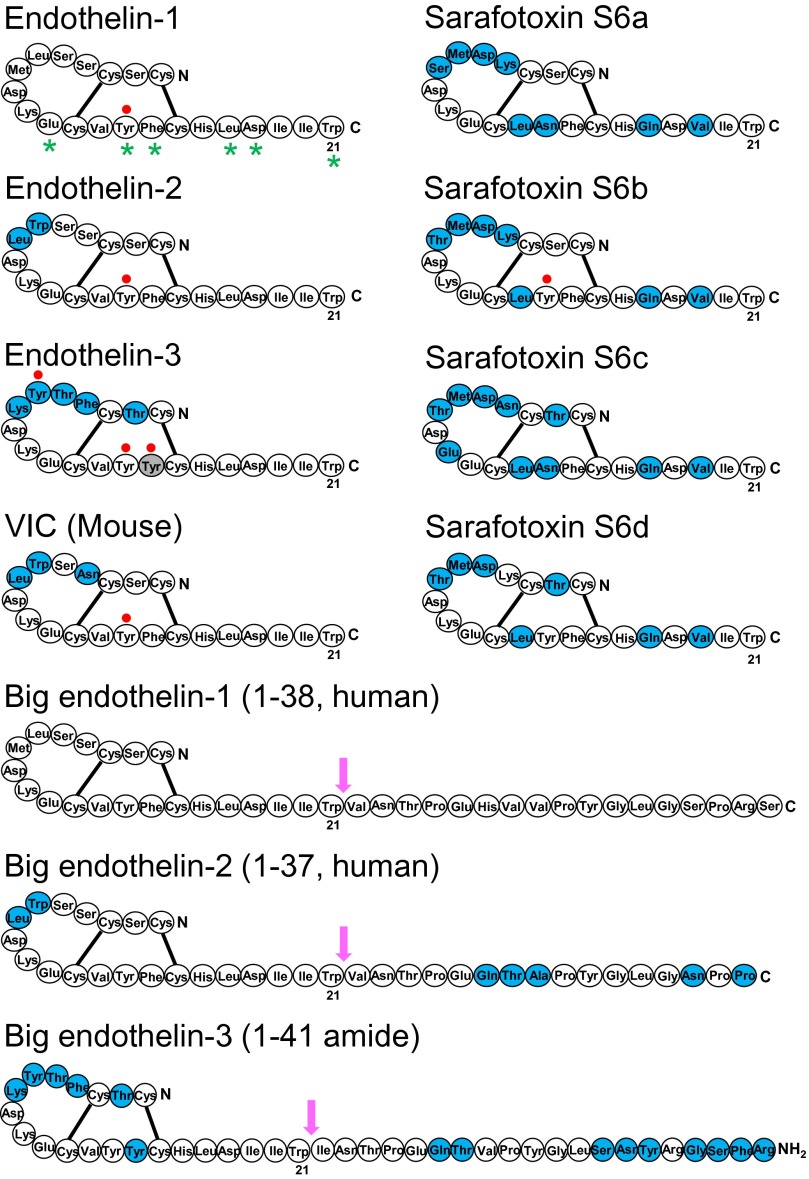
Schematic diagram showing the sequences of ET, Big ET precursors and sarafotoxin peptides. Amino acids that differ between ET-1 and mature peptides or between Big ET-1 and precursors are shown in blue. Labeling of [125I] radioligands at Tyr residues are shown by a filled red circle. Residues that are thought from X-ray crystallography to be aligned as a stripe as a result of a secondary helical structure secondary helical structure are indicated with a star (Janes et al., 1994; Orry and Wallace, 2000). These residues have also been shown experimentally to be crucial for binding (Huggins et al., 1993). Arrows indicate the site for cleavage of Big ETs to mature peptides: between Trp21-Val22 amino acids for Big ET-1 and ET-2 and between Trp21-Ile22 for ET-1 and for Big ET-3.